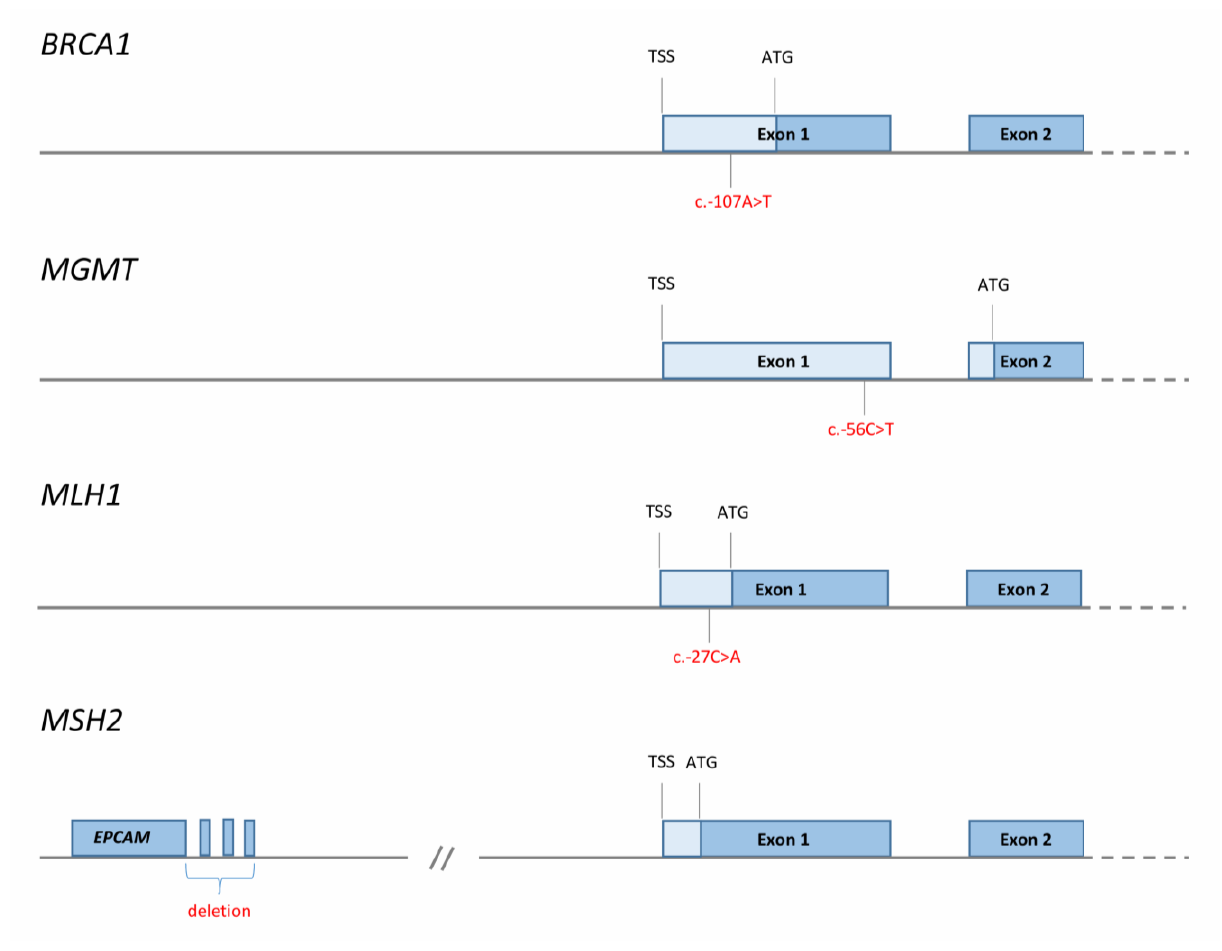
FIGURE 3: Reported cis -acting factors (red font) causing tumour suppressor promoter methylation and cancer risk [35, 43, 58, 133]. TSS; transcription start site, ATG; translational start site, blue boxes; protein coding regions, pale blue boxes; 5’UTR.